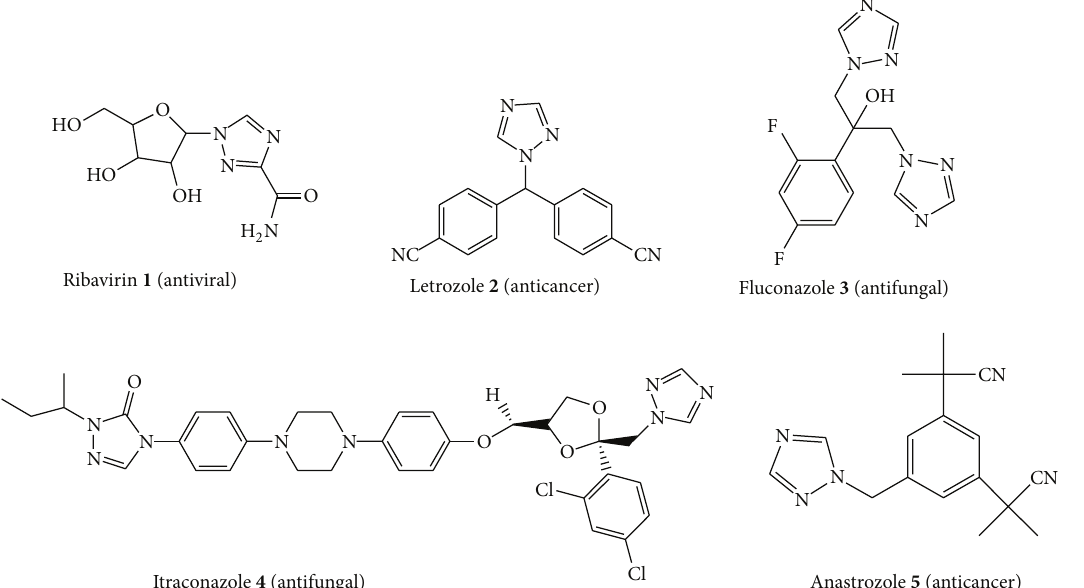
Figure 1: Some 1,2,4-triazole based medicine currently in